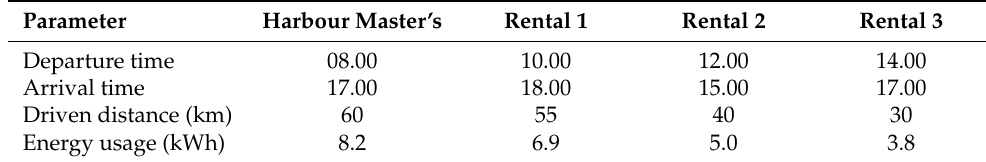
Table 2. Typical daily usage pattern of electric cars at Ballen marina.